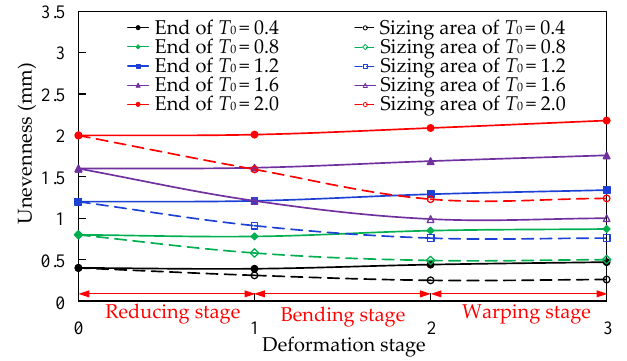
Figure 23. Evolution process of unevenness.